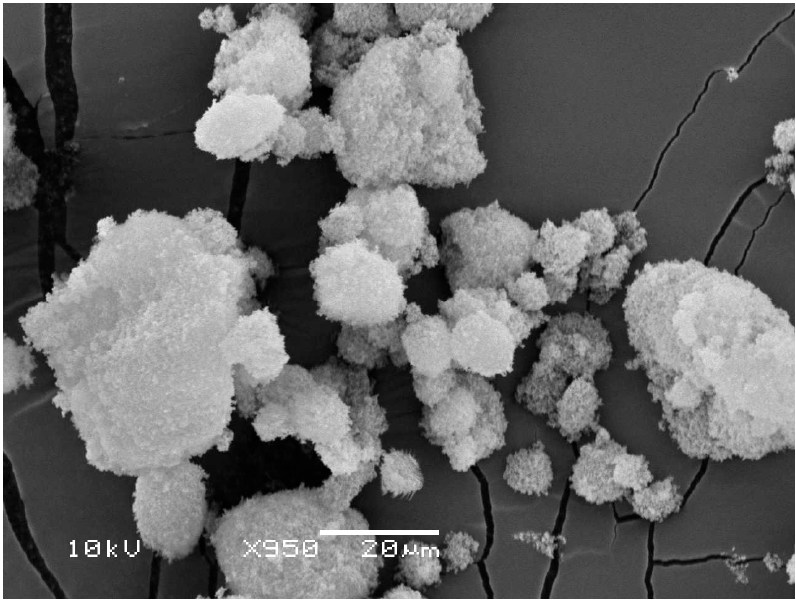
Figure 3. SEM image showing size distribution of nanoagglomerates of sieved sample.